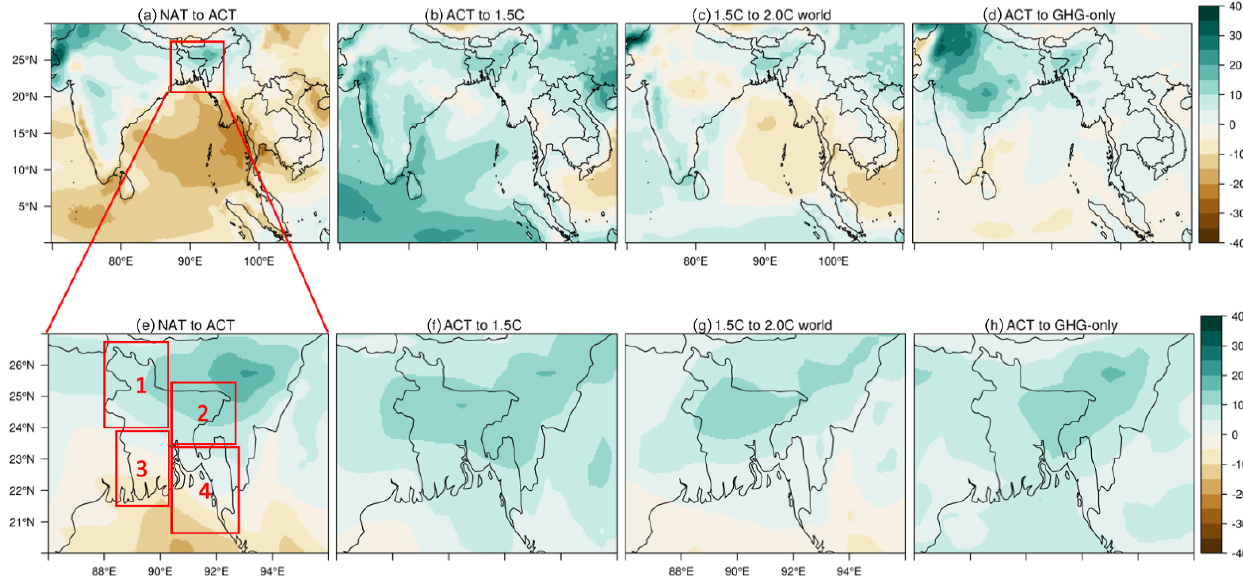
Figure 2. Percentage change (dPercent) in MAM mean rainfall between different forcing scenarios. (a) – (d) shows the regional dPercent over central parts of South Asia (SA). (a) ACT rainfall dPercent relative to NAT over SA (b) . ACT rainfall dPercent relative to HAPPI 1.5 ◦ C over SA (c) , HAPPI 1.5 ◦ C rainfall dPercent relative to HAPPI 2.0 ◦ C over SA (d) . ACT rainfall dPercent relative to GHG-only. Bottom row (e) – (h) shows dPercent in the same way but over Bangladesh. The four boxes (1–4) of panel (e) represent the four sub-regions of